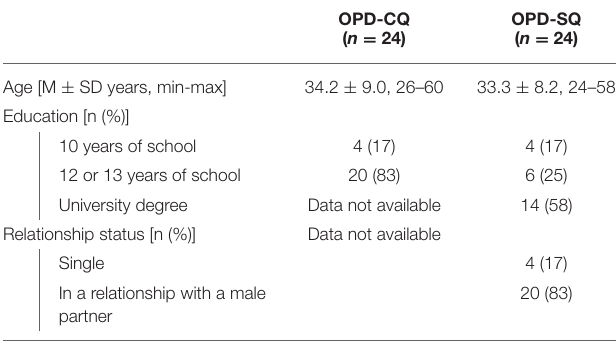
TABLE 2 | Sample characteristics control